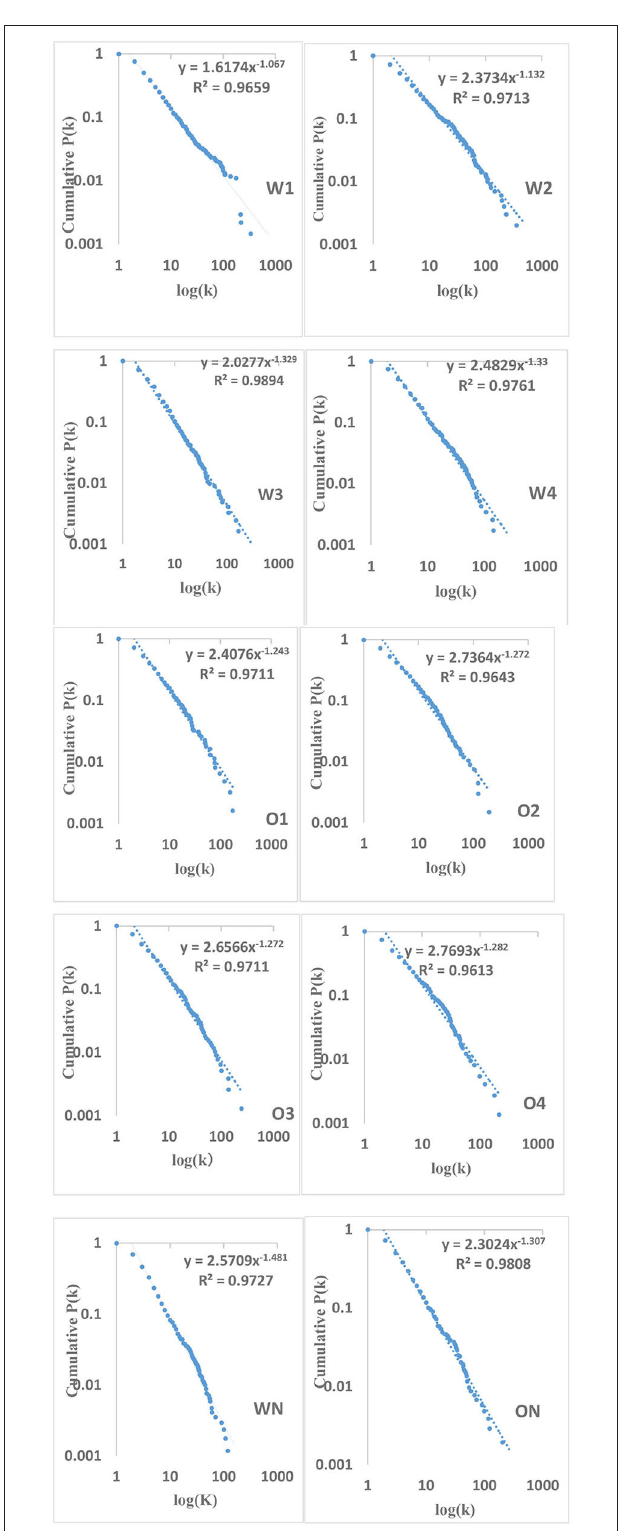
FIGURE 4 | Syntactic dependency networks’ cumulative degree